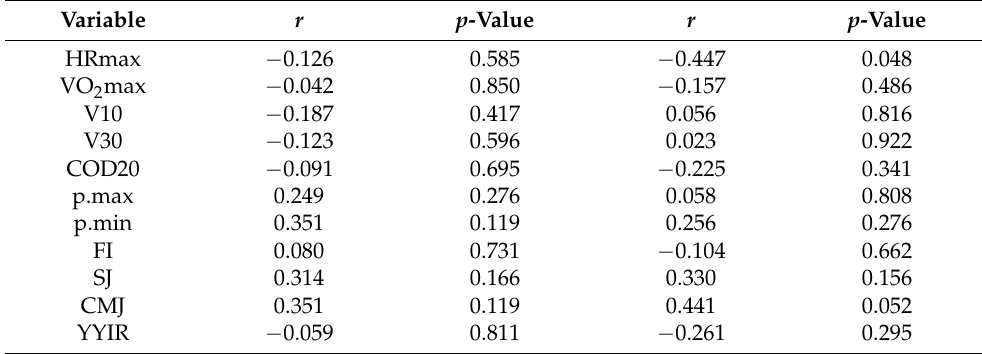
Table 2. Correlations between mean values fitness and average training